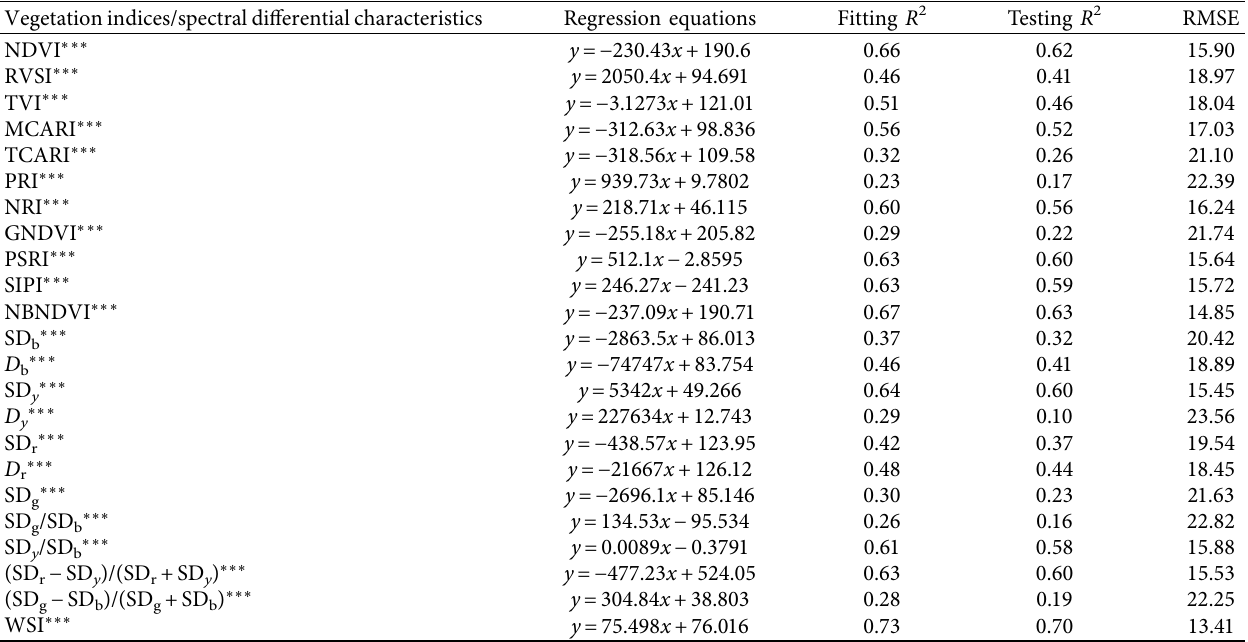
Table 3: Unitary linear regression results of vegetation index and spectral differential characteristics.